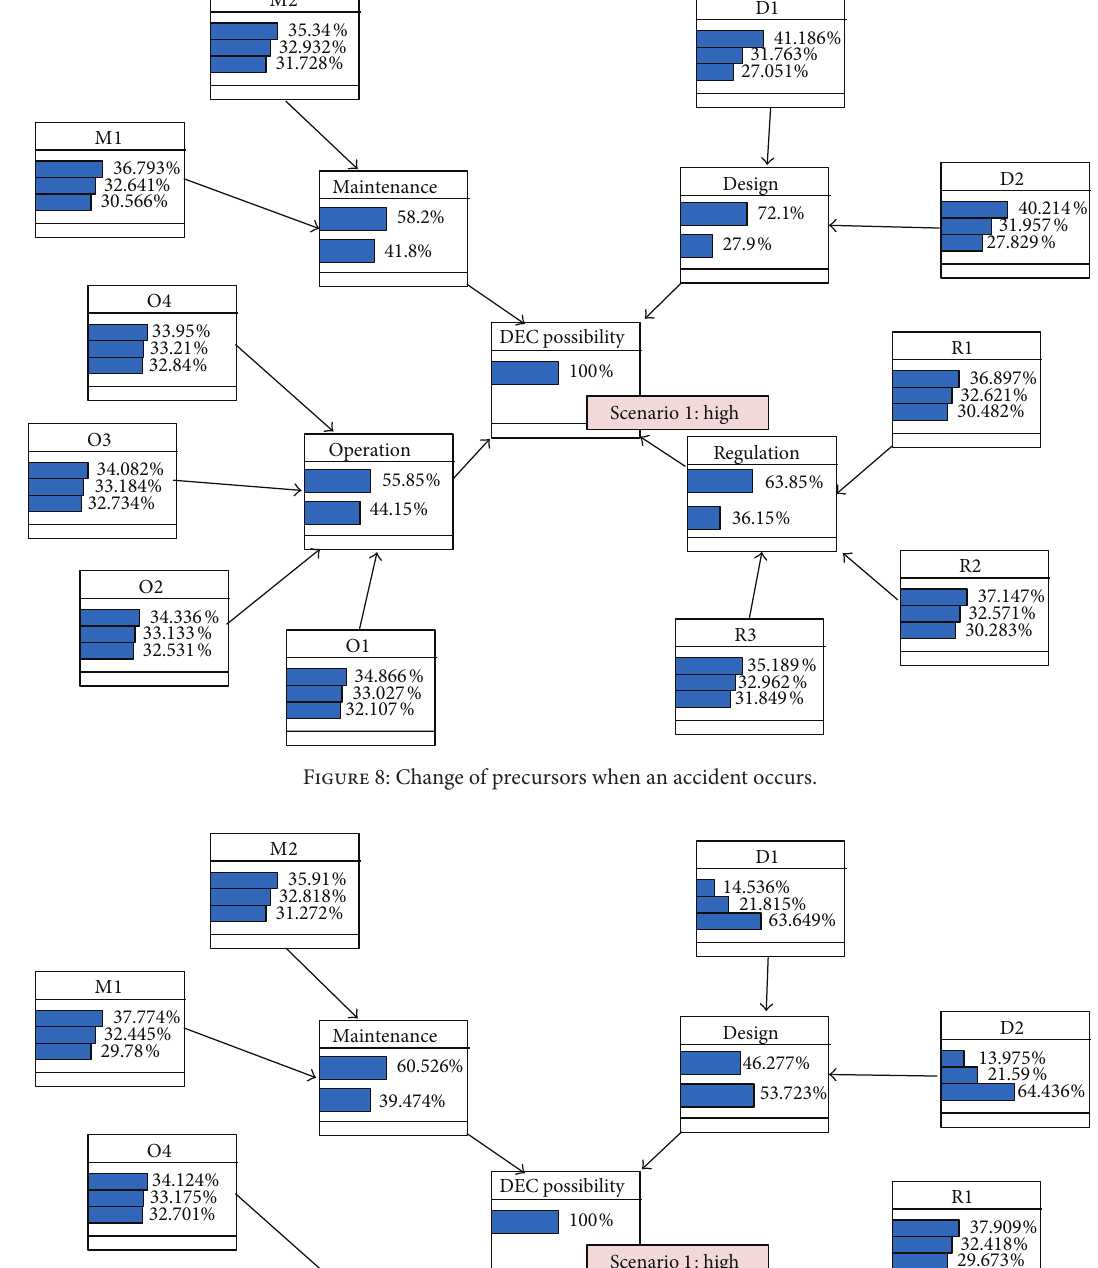
Figure 9: Change of precursors when strengthening D1 and